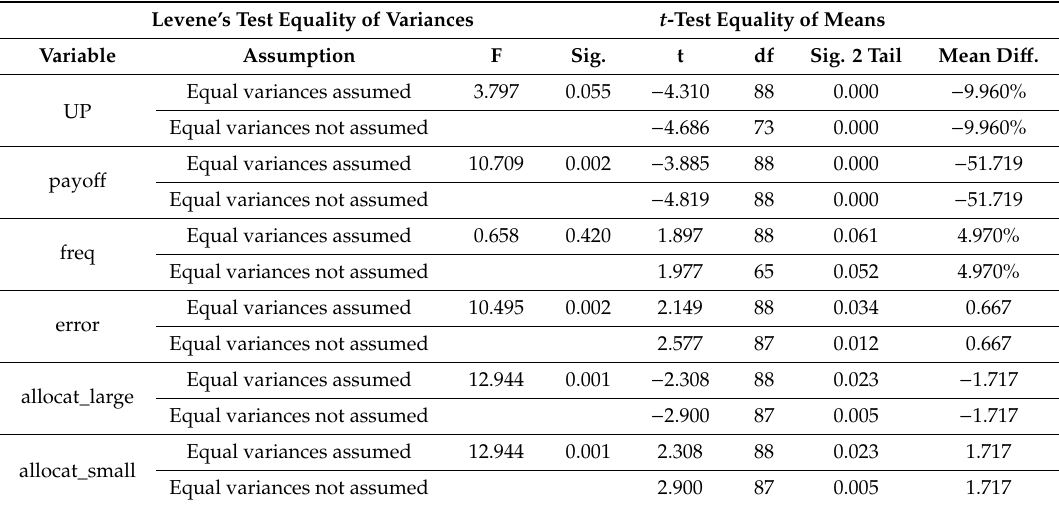
Table 9. Levene’s test for the equality of variances and the t -test for the equality of the means of the outcomes of the auction with the highest and lower capacity